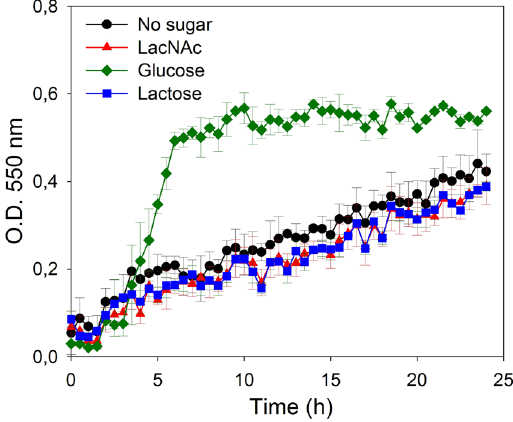
Figure 7. Growth curves of Lactobacillus casei mutant strain BL195 ( lacT ) on sugar-free MRS without carbon source (black), with N -acetyllactosamine (LacNAc) (red), glucose (green) or lactose (blue). Data presented are mean values based on at least three replicates. Error bars indicate standard